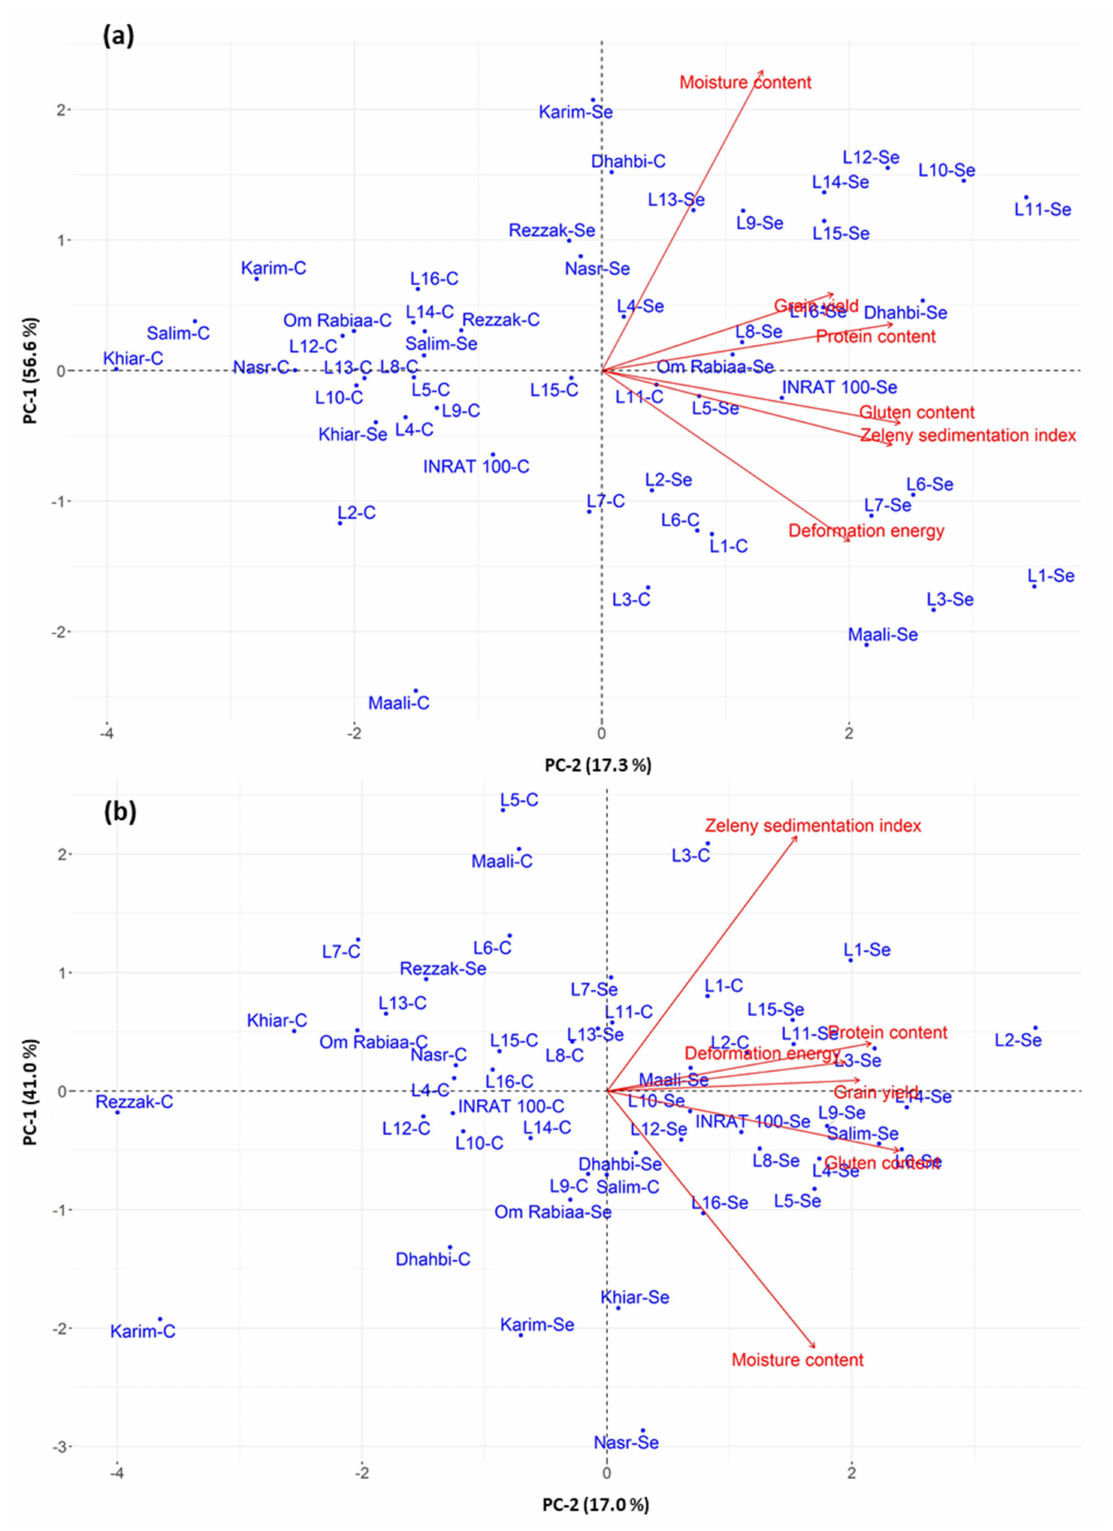
Figure 3. Two-dimensional principal component analysis (PCA) of all combinations (cultivar-treatment) for grain yield and quality attributes under the Kef–Boulifa ( a ) and Beja ( b )